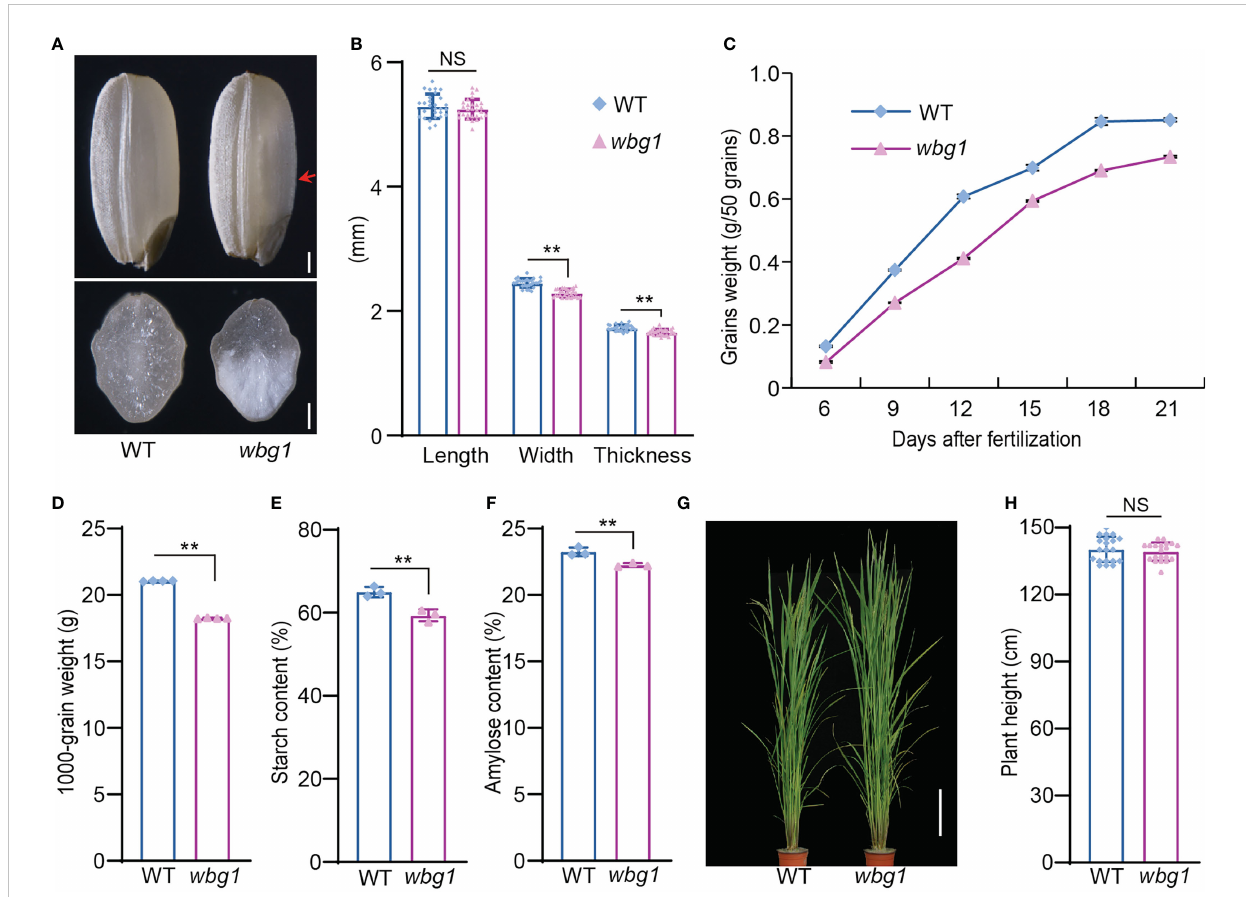
FIGURE 1 wbg1 phenotype. (A) The outer (upper panel) and cross-section (lower panel) phenotypes of wild-type (WT) and wbg1 grains. The belly side of the wbg1 grain is indicated by the red arrowhead. (B) Grain length, width, and thickness of WT and wbg1 grains. (C) Grain fi lling rates of WT and wbg1 . (D) Thousand-grain weights of WT and wbg1 . (E) Starch content of WT and wbg1 grains. (F) Amylose content of WT and wbg1 grains. (G) Plant phenotypes of WT and wbg1 at the grain- fi lling stage. Scale bar = 20 cm. (H) Plant heights of WT and wbg1 at the grain fi lling stage. Values are presented as mean ± standard deviation (SD) (** p < 0.01; Student ’ s t -test). NS, not signi fi